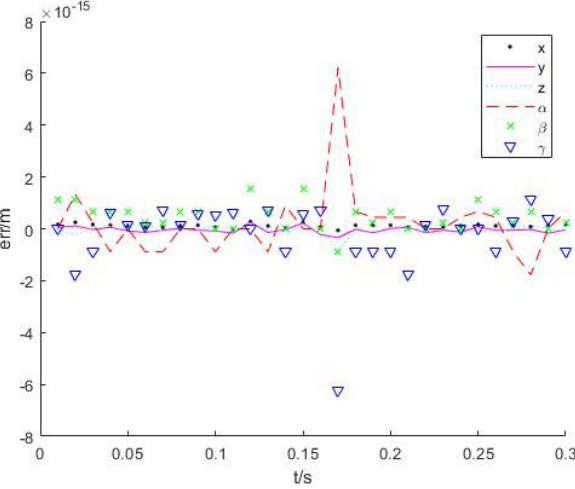
Figure 5. Analytical inverse solution error.